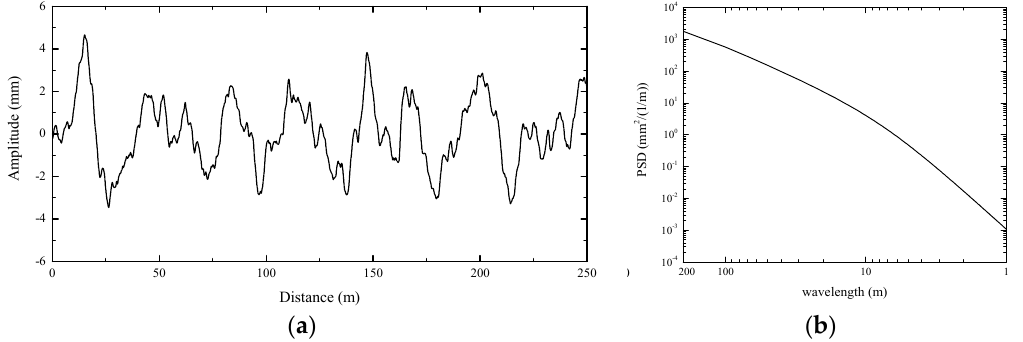
Figure 2. Track irregularity ( a ) track irregularity with distance and ( b ) power spectrum density (PSD) with wavelength. Table 1. Properties of the vehicle and slab track; CRH380 EMU = China Railway High-speed (CRH) 380 Electric Multiple Unit; CRTS = China Railway Track System; CA = cement